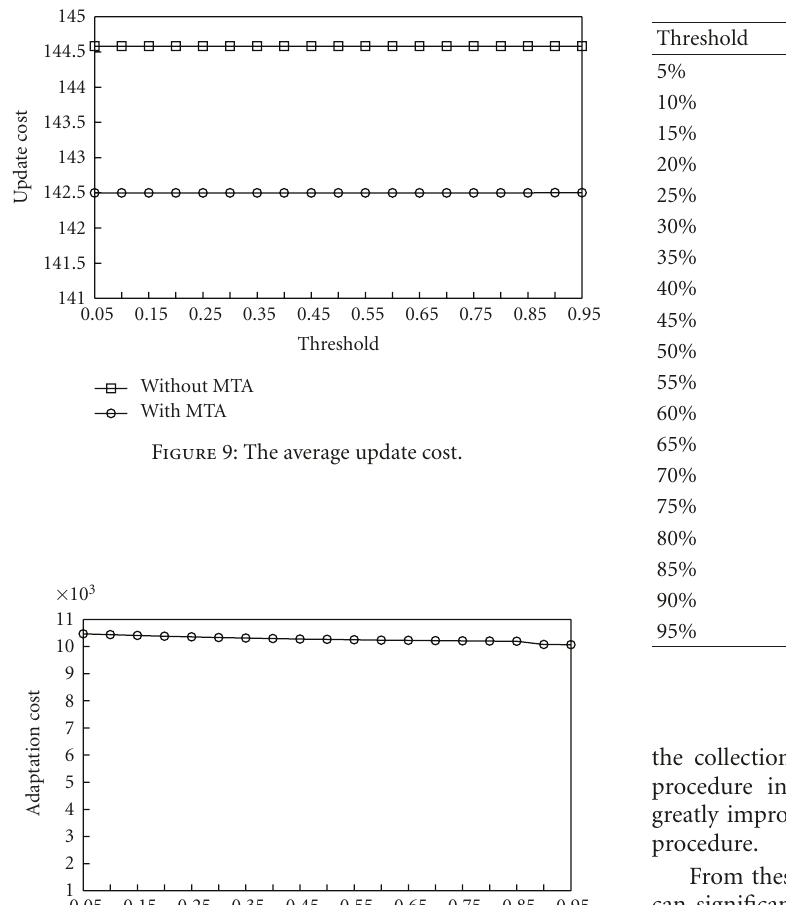
Table 1: The Improvement Percentage using MTA